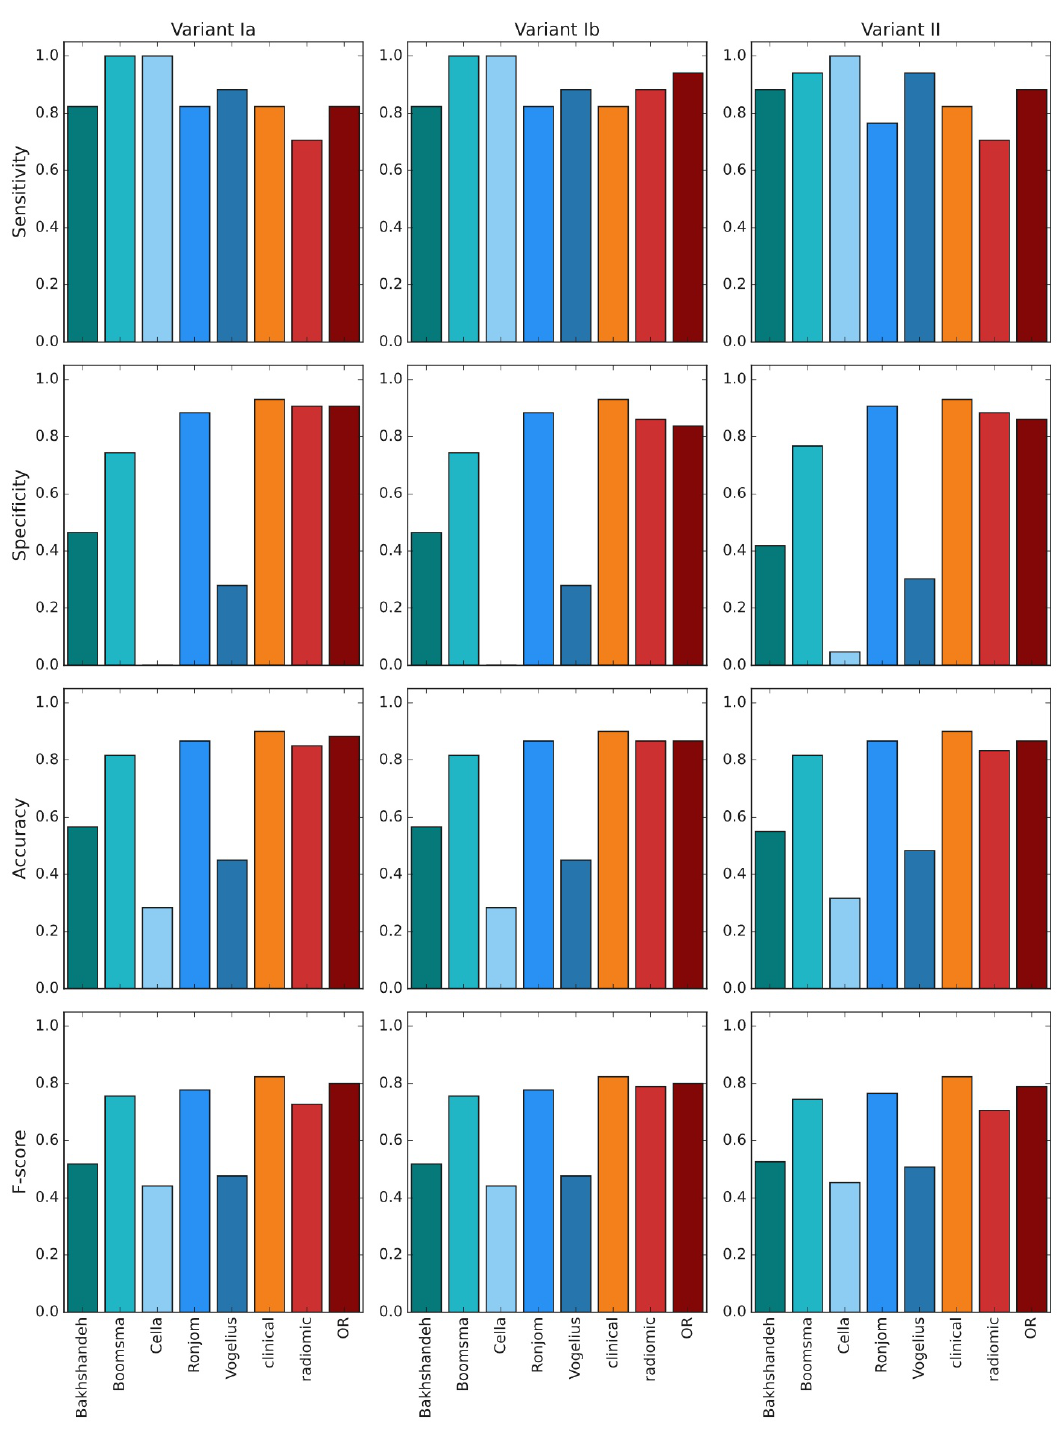
Figure 5. Comparison of quality measures between external NTCP models (cool colors, 5 bars from the left) and our top model selections (warm colors, 3 bars from the right), validation